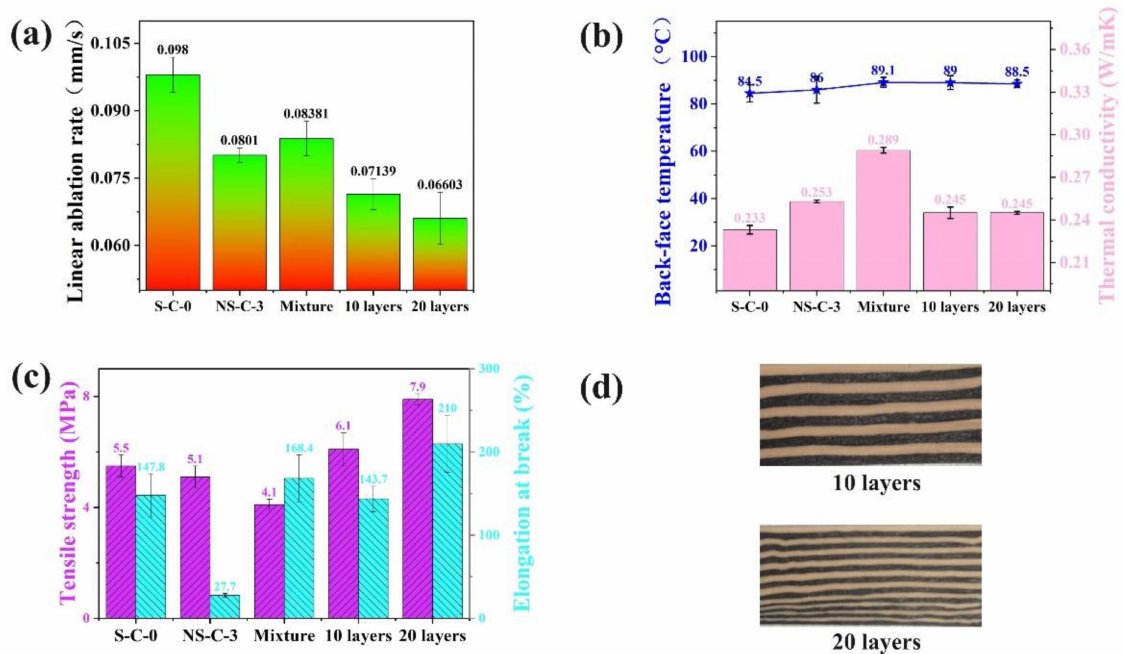
Figure 8. The ablation resistance ( a ), thermal insulation performance ( b ), mechanical properties ( c ) and morphology ( d ) of multilayer